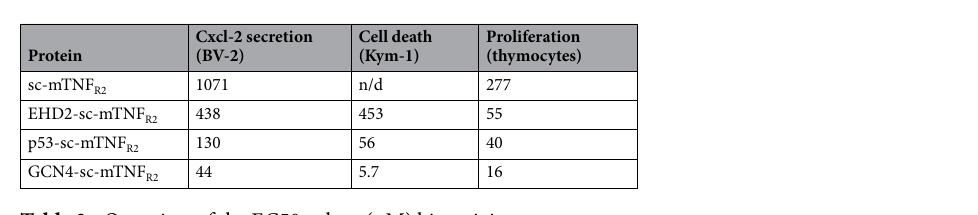
Table 3. Overview of the EC50 values (pM) bioactivity